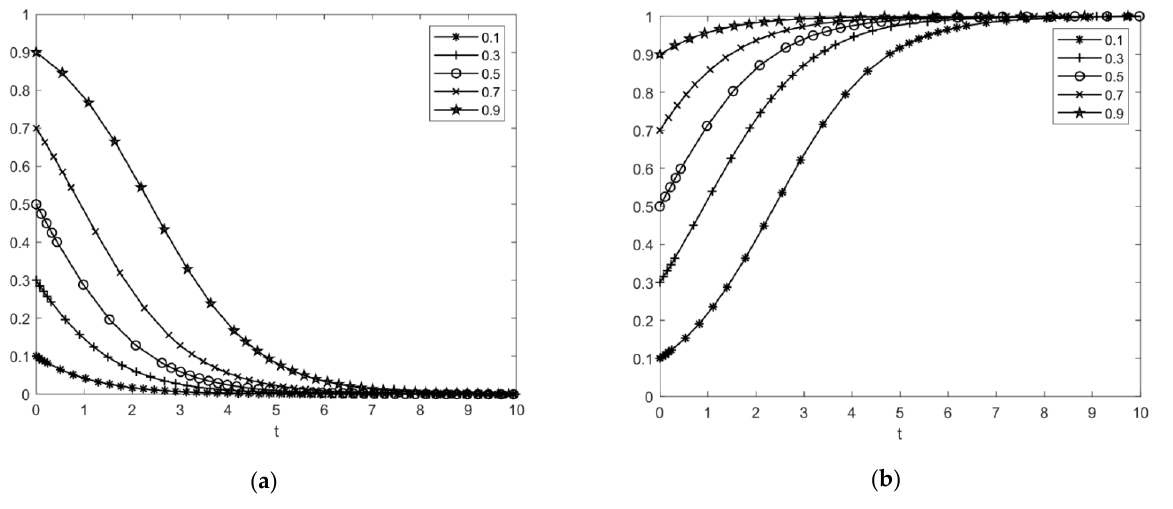
Figure 6. Cooperation willingness. ( a ) y = 0.3, ( b ) y = 0.7.